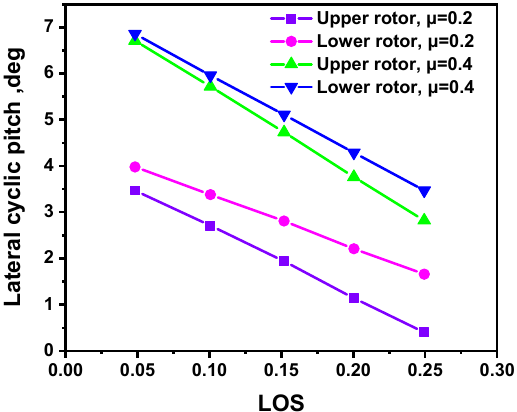
Figure 15. Coupled collective pitch ( θ (cid:2868).(cid:2875) ) as a function of the lift offset (LOS).